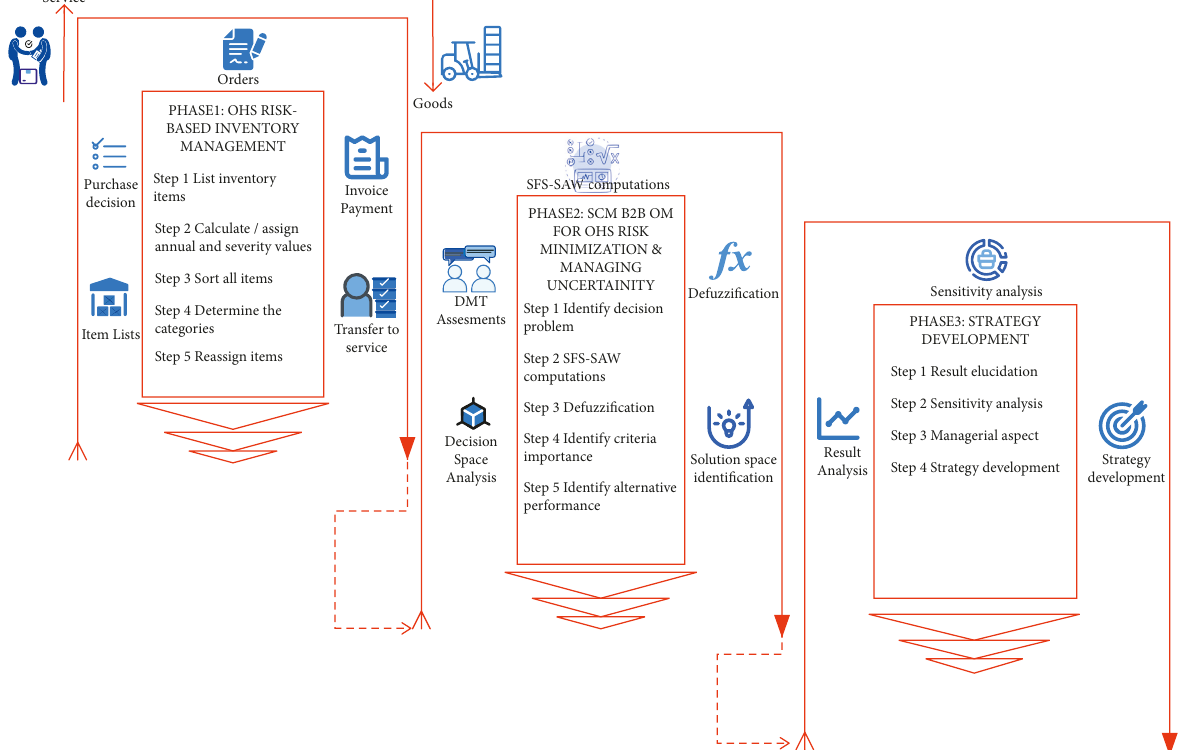
Figure 2: The proposed approach to minimize OHS